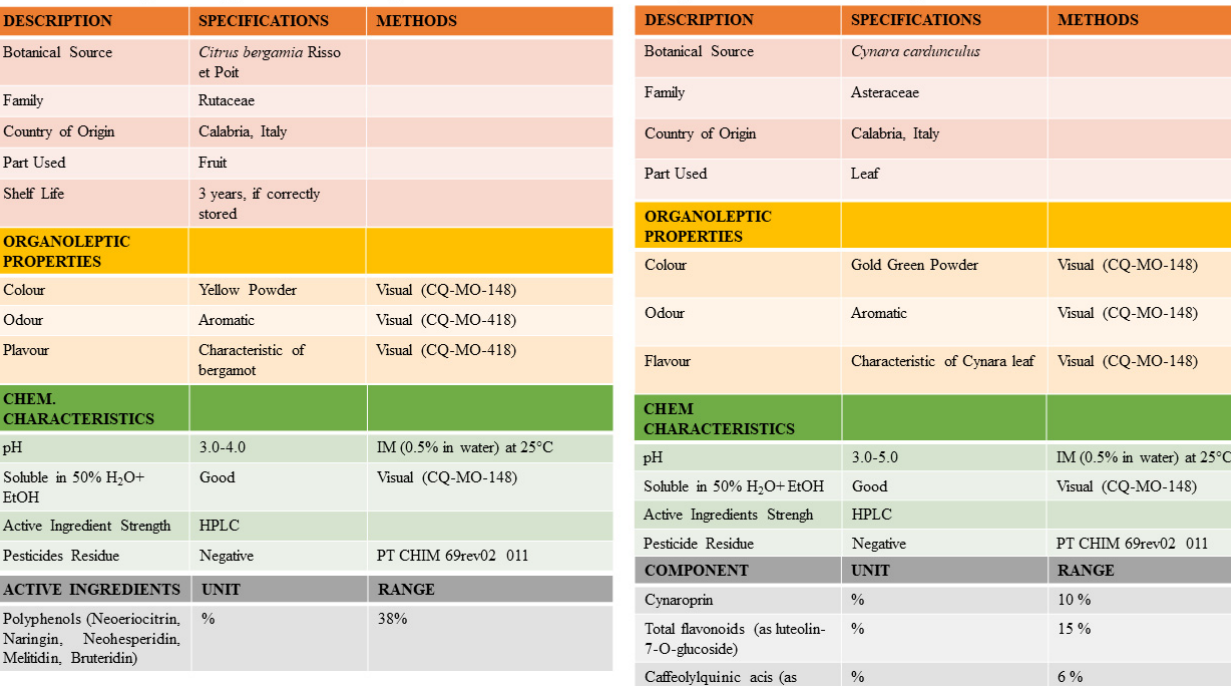
Figure 3. Datasheets of BPF and Cynara cardunculus . The specification sheet and the comparison between BPF and Cynara cardunculus and chemical characteristics and the composition of the main components of both compounds. This data was provided by by HEAD srl (Bianco, Italy).